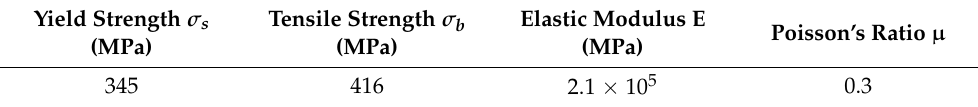
Table 2. Basic mechanical parameters of Q345B.